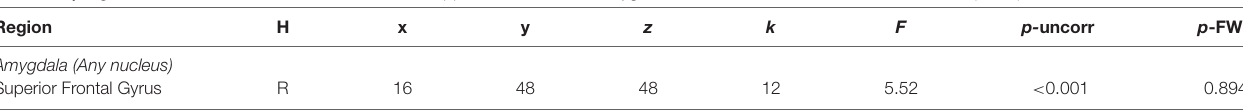
TABLE 4 | Significant clusters associated with neuronal reappraisal success for amygdala nuclei as seeds restricted to PFC mask (aim 3). Region H